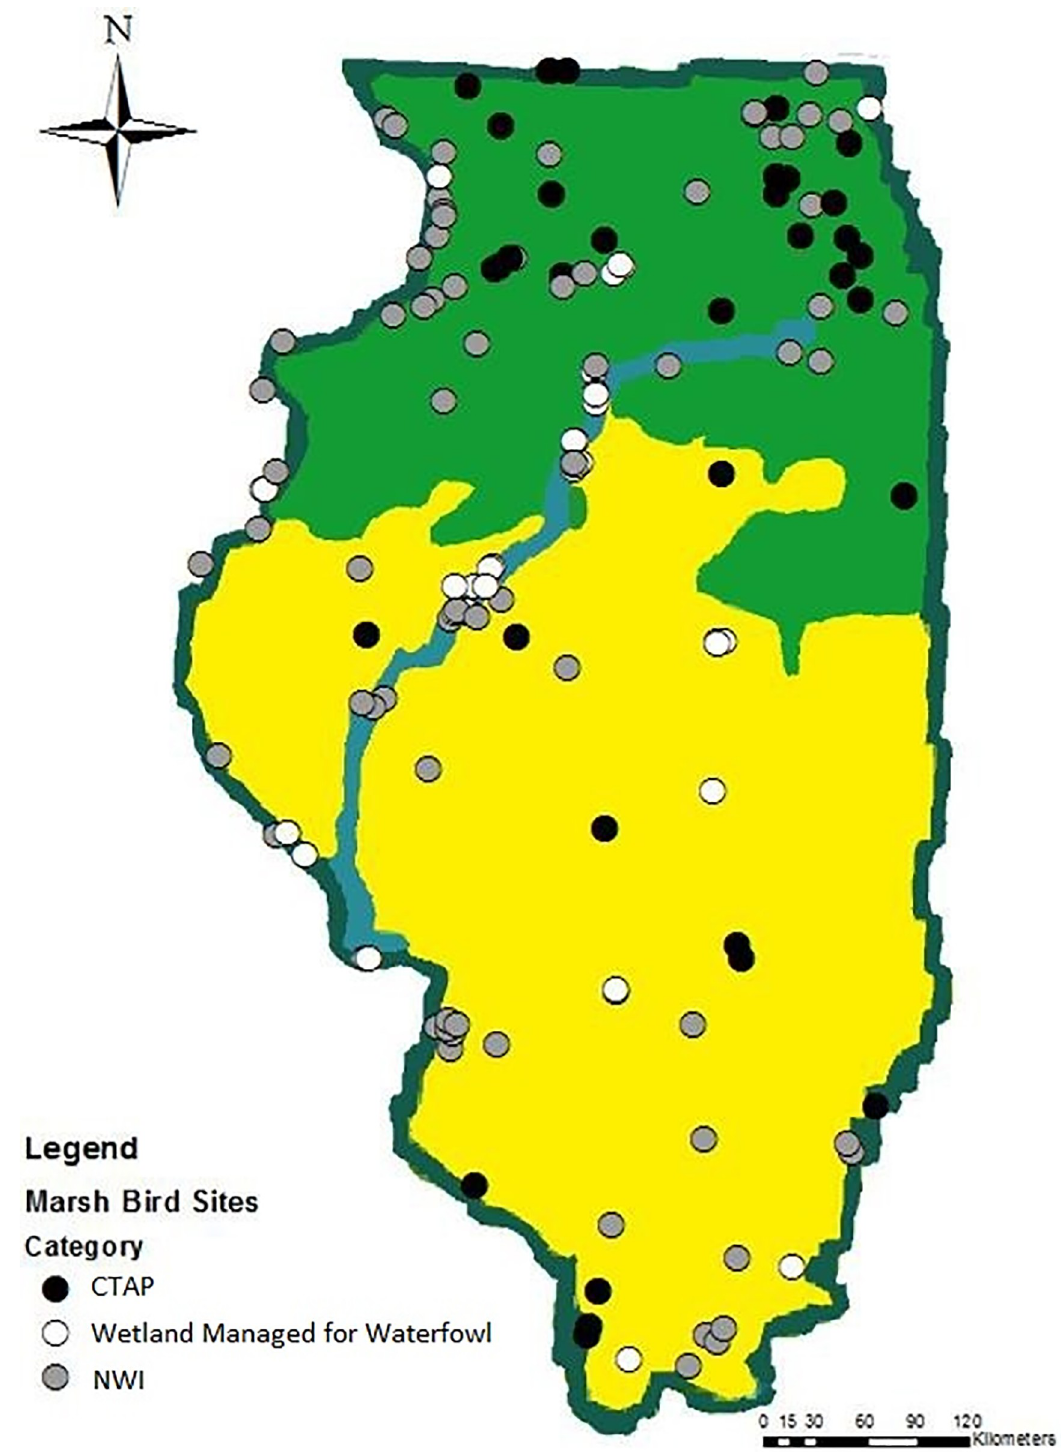
Fig 1. Marsh bird survey sites for two regions of Illinois categorized by average maximum temperatures in May from the PRISM Climate Group at Oregon State University (Conway 2011). Sites consisting of National Wetland Inventory (NWI; grey), wetlands managed for waterfowl (white), and Critical Trends Assessment Program (CTAP; black) wetlands.